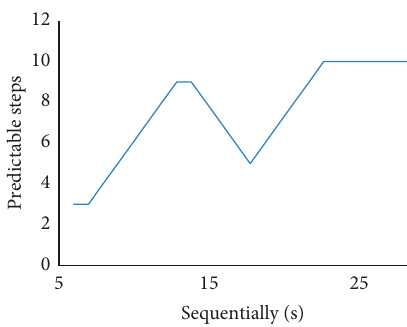
Figure 4: The actual steps for speed.